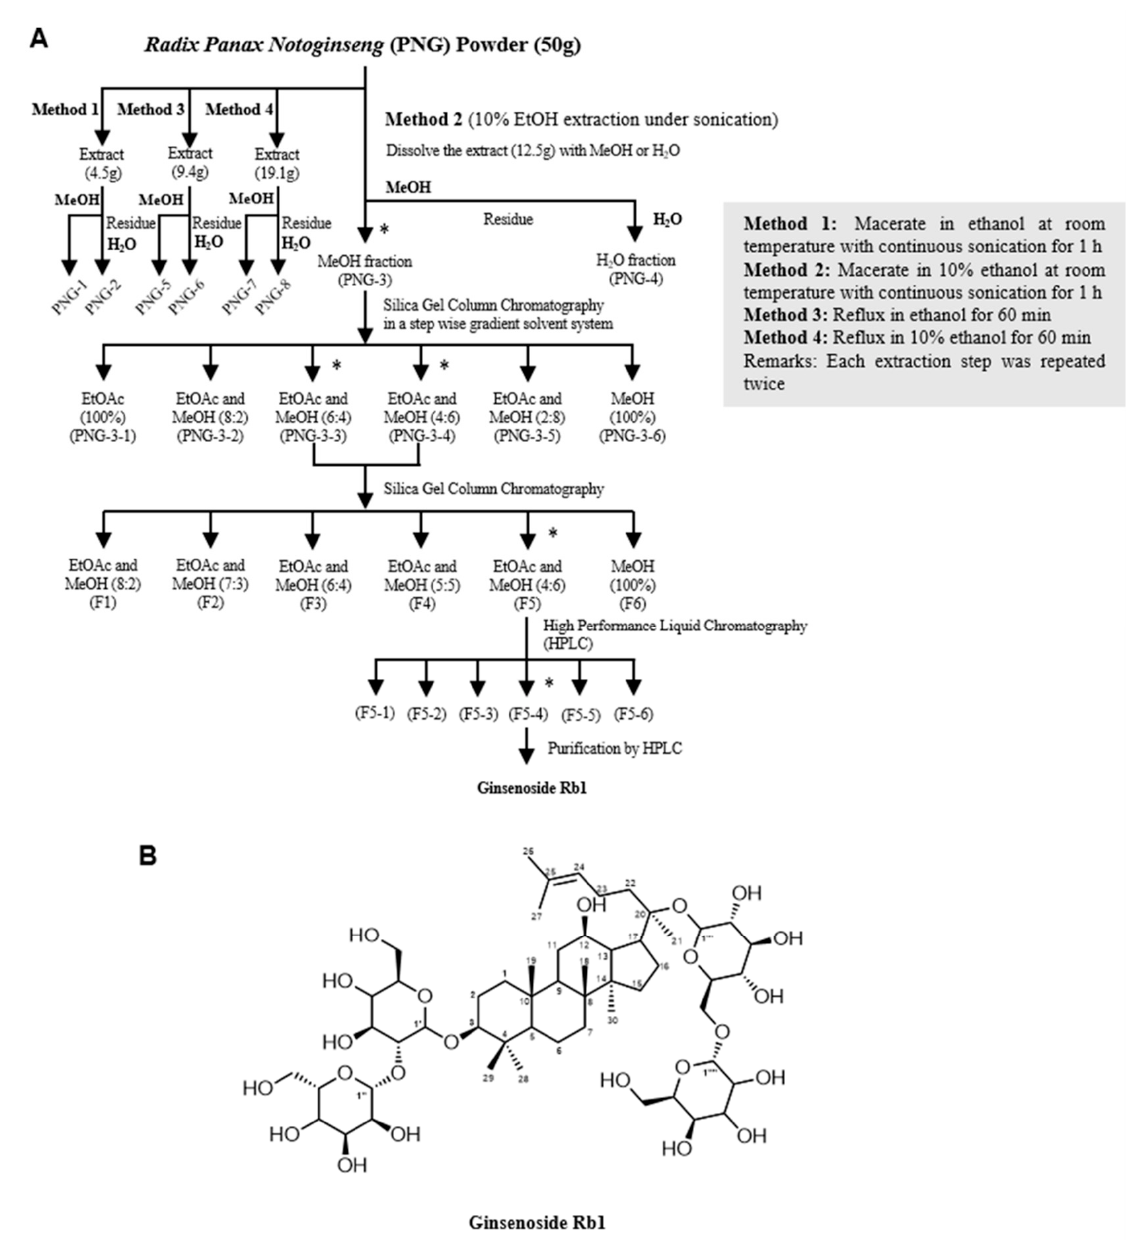
Figure 2. Isolation and identification of the bioactive compound Ginsenoside Rb1 (GsRb1). ( A ) The extraction scheme of GsRb1 from Panax notoginseng (PNG). PNG powder was first sonicated in 10% ethanol (EtOH) at room temperature. The dry extract was further successively dissolved in methanol (MeOH), and the residue was dissolved in water (H 2 O). The extracts were tested for their inhibitory effects on MMP-9 activity on TNF- α -induced H9c2 cells. The most potent extract, PNG-3, was further separated using column chromatography and reverse-phased HPLC until a single bioactive molecule was isolated. * Represents the fractions with inhibitory effect on TNF- α -induced MMP-9 activity. Other extraction methods (Method 1, 3 and 4) are also summarized. ( B ) Chemical structure of Ginsenoside Rb1.